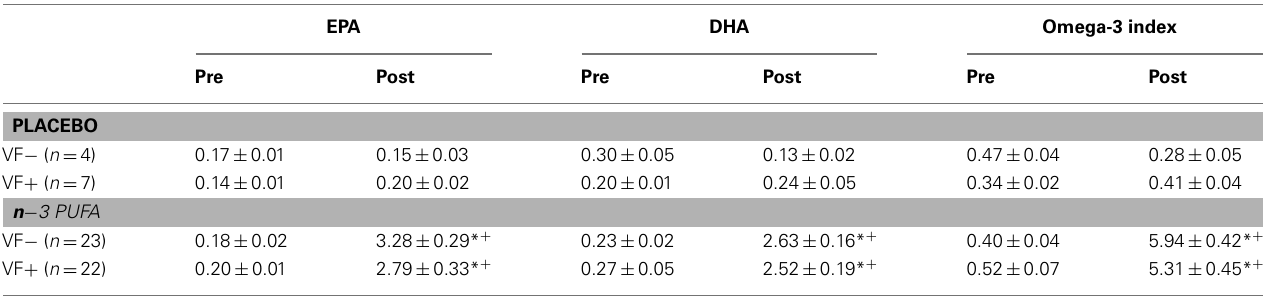
Table 1 | Red blood cell omega-3 polyunsaturated fatty acid